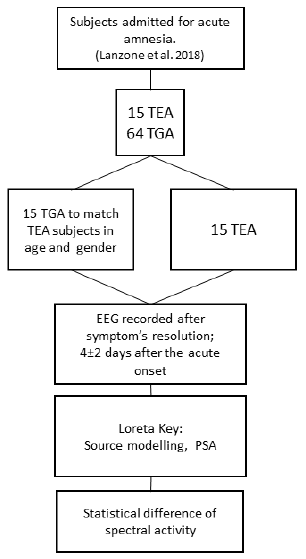
Figure 1. Depicts the flow chart of the study. TEA (Transient Epileptic Amnesia); TGA (Transient Global Amnesia).